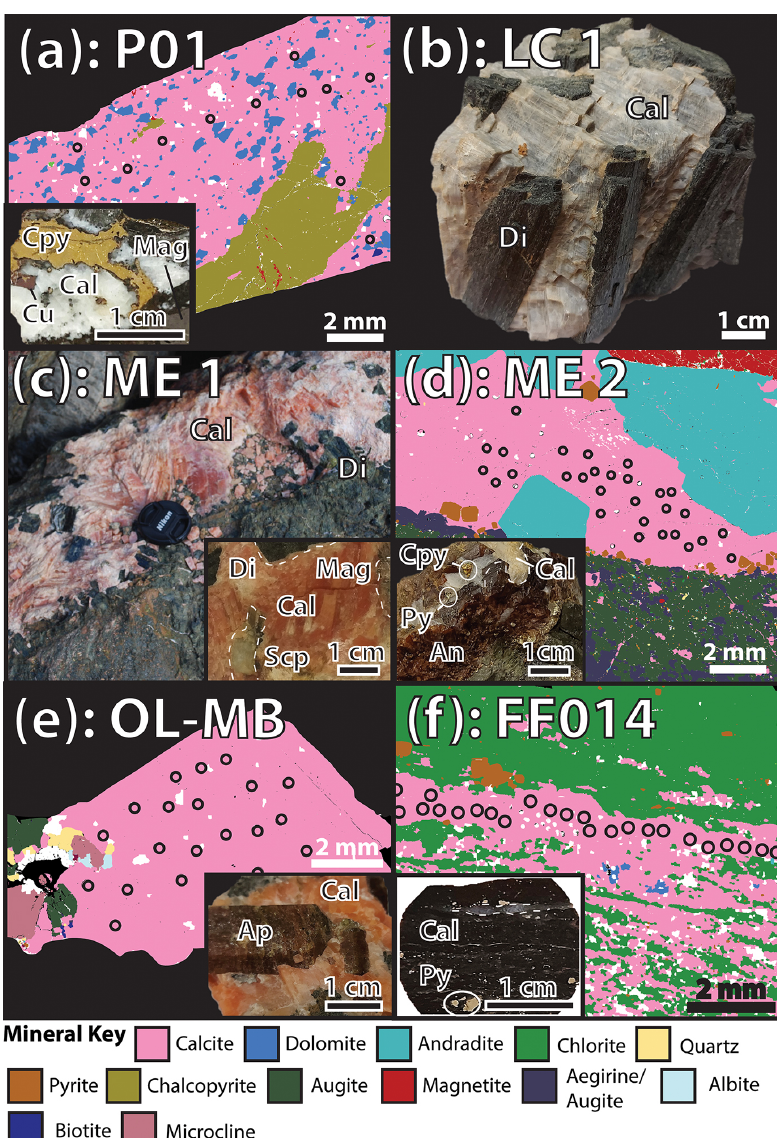
Figure 1. A combination of SEM mineral maps (a, c, d, e) and photos of analysed samples. (a) P01 (Phalaborwa carbonatite) shows calcite in petrogenetic context to chalcopyrite. (b) Photo of LC 1 hand sample. (c) Photo of the ME 1 sample in outcrop, with inset showing the mineralogy of the analysed sample. (d) Calcite from ME 2 (Mt Isa) in contact with hematite, pyrrhotite, and andradite, with inset showing hand sample. (e) OL-MB (Otter Lake), showing analysed calcite with associated minerals, with inset showing relationship between apatite (Ap) and calcite (Cal) in hand sample. (f) FF014 (Flin Flon deposit) shows calcite vein in chlorite matrix with disseminated pyrite, with inset showing analysed block (dark coloured matrix is composed of chlorite). Black circles represent laser spot locations. Mineral abbreviations: Cal – calcite; Cpy – chalcopyrite; Py – pyrite; Mag – magnetite; Cu – cubanite; Di – diopside; Scp – scapolite; An – andradite. Larger-size sample images are included in Appendix